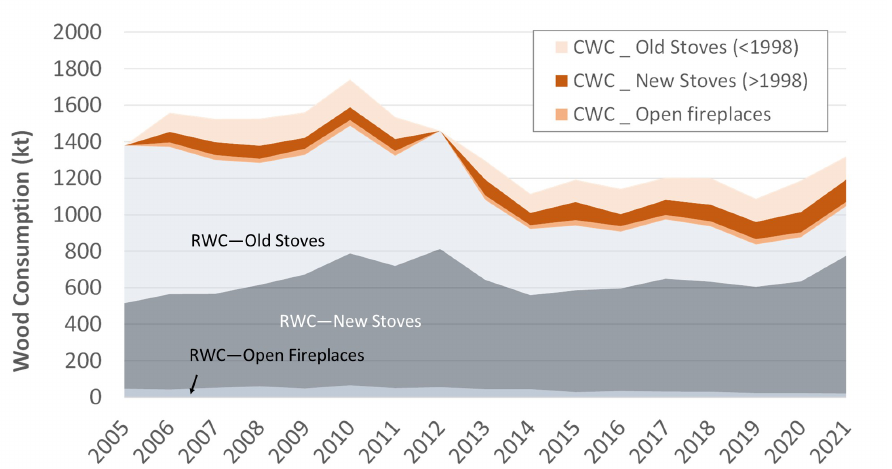
Figure 2. Wood combustion (kt) for residential (gray tones) and cabin heating (orange tones) split per technology in old stoves (manufactured before 1998), new stoves (manufactured after 1998) and open